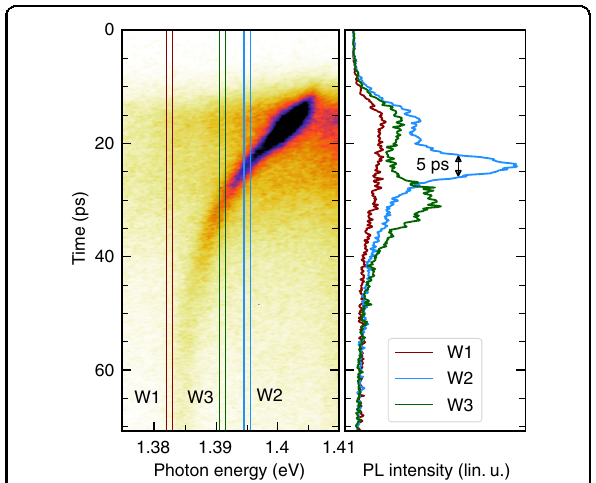
Fig. 8 Emission of a few ps light pulse by frequency-selected QDs in a switched QDM. The streak camera image is obtained for a 1.6 µm diameter switched QDM (Q = 2000), and temporal pro fi le of the PL signal that is collected for three 1 meV-wide frequency windows, positioned below (1.383 eV for W1), or above (1.395 eV for W2, 1.391 eV for W3), the frequency of the fundamental mode in the unswitched QDM (cid:1) h ω